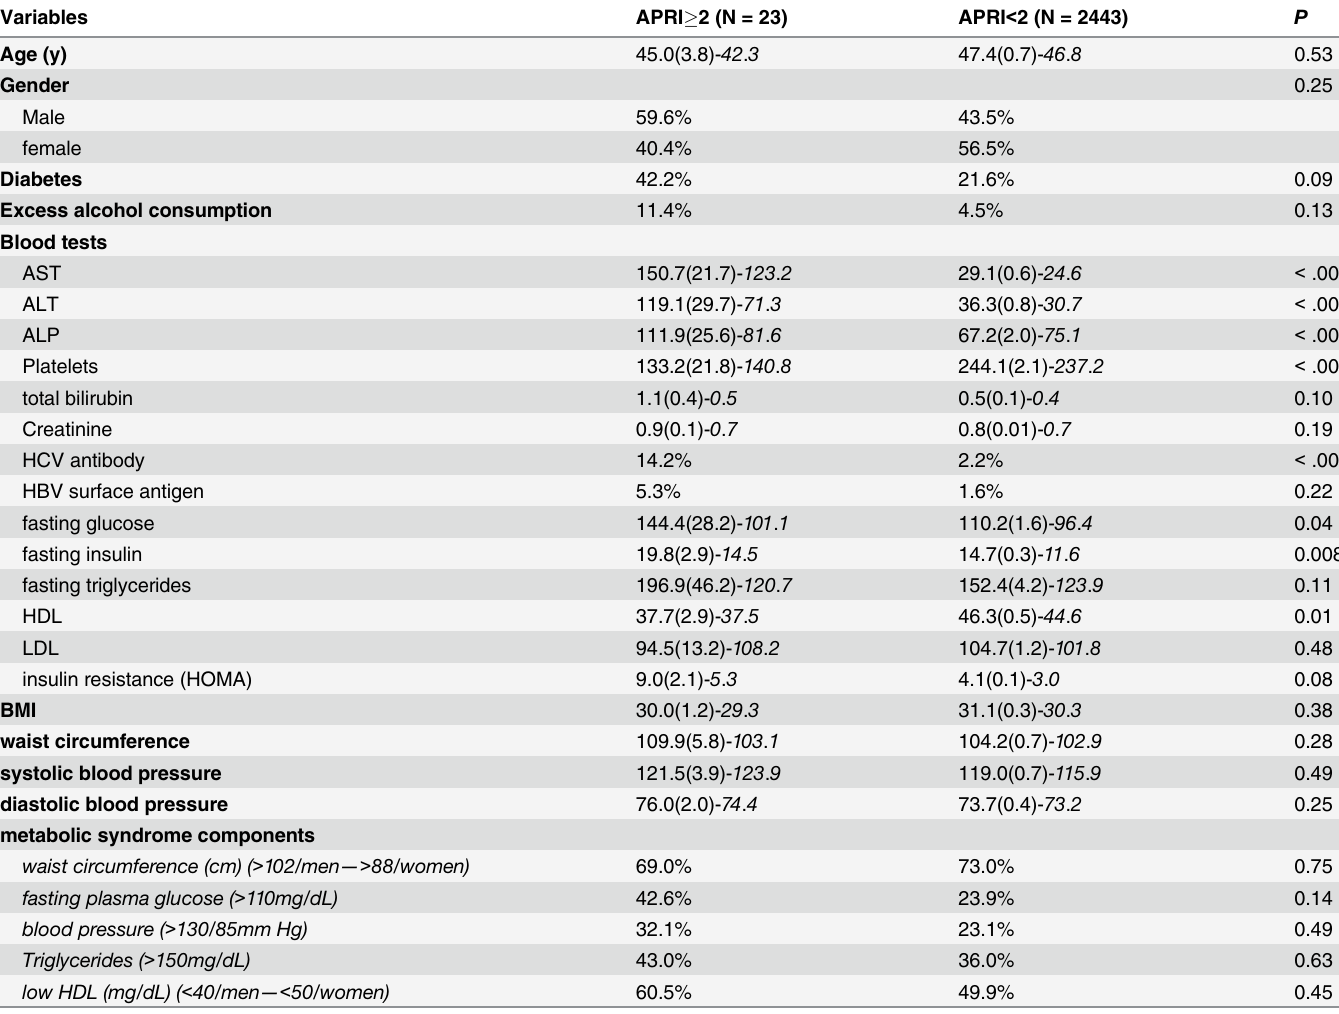
Table 1. Demographic, clinical, and laboratory variables by cirrhosis status (APRI 2